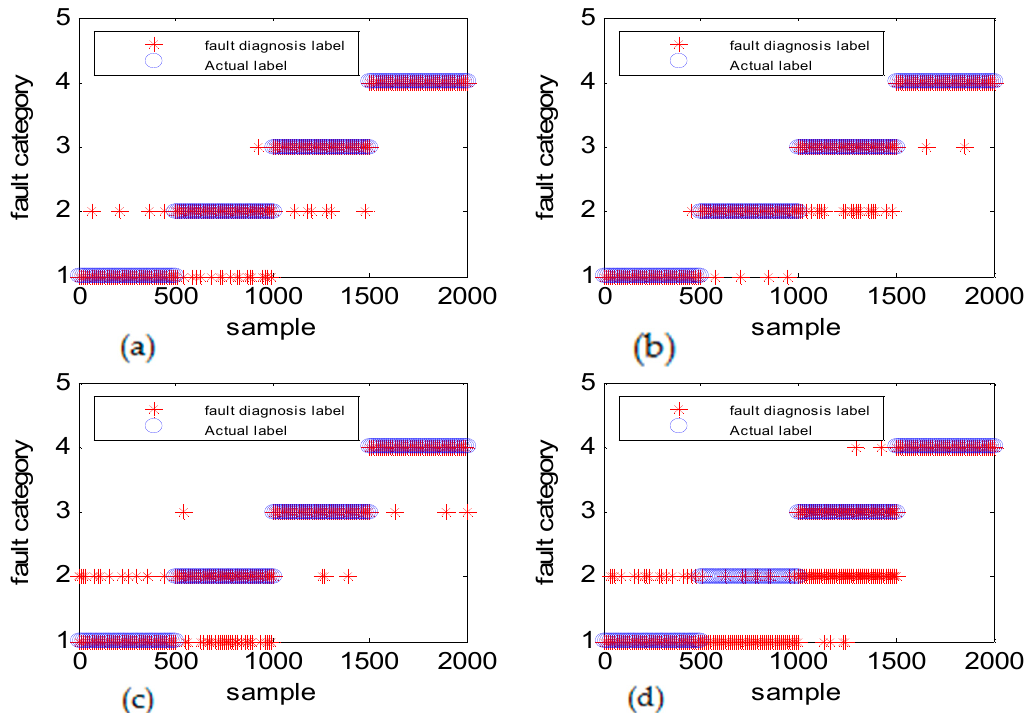
Figure 17. Case study results for diagnosis for different fault sizes: ( a ) DGFFDNN, ( b ) DNN, ( c ) DGFFBP, and ( d ) BP.